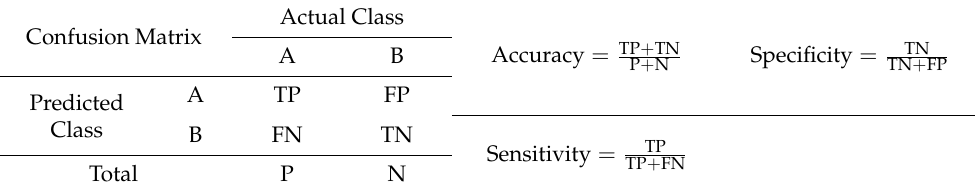
Table 2. Confusion matrix and evaluation parameter